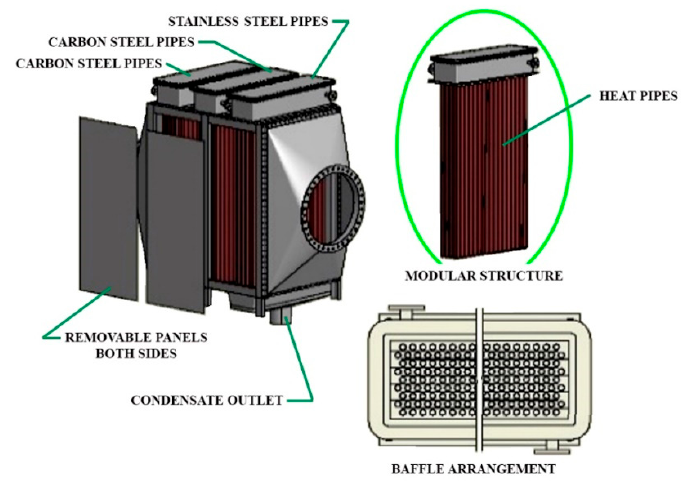
Figure 3. Schematic repre-